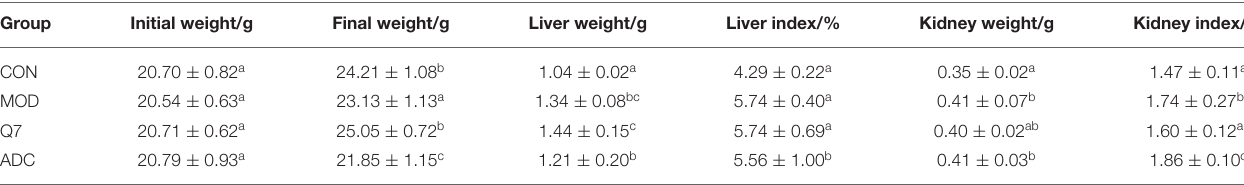
TABLE 2 | Effects of L. plantarum Q7 on body weight, organ weight, and visceral Co-efficient in mice. Group